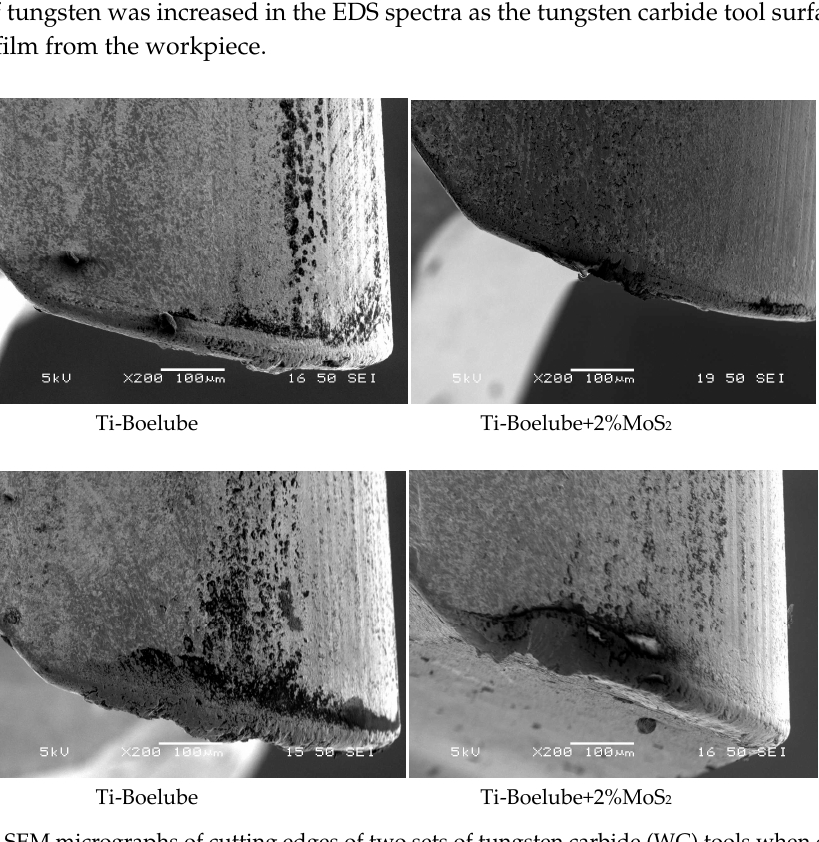
Figure 4. SEM micrographs of cutting edges of two sets of tungsten carbide (WC) tools when cutting Ti with Boelube and Boelube+2%MoS 2 .